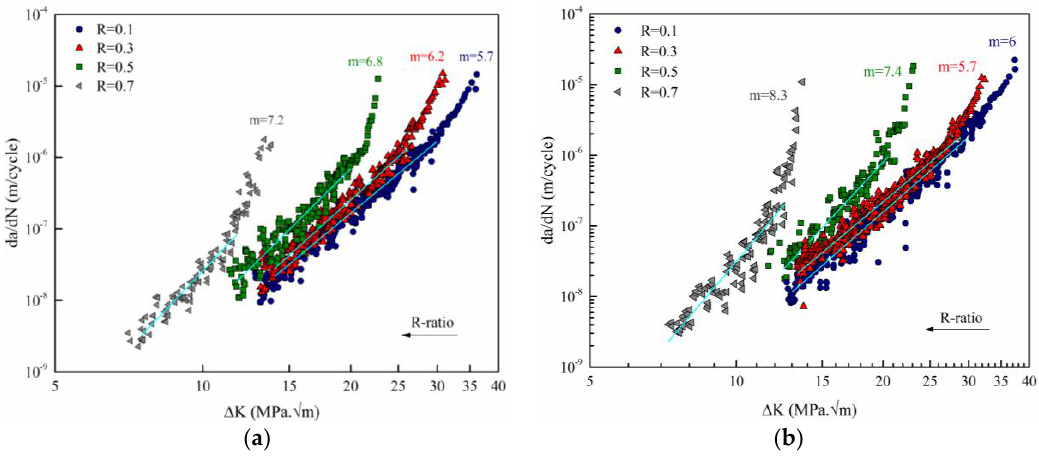
Figure 3. Fatigue crack growth rate vs. stress intensity factor range of the ( a ) admixed and ( b ) pre-alloyed PM steels at four tested R -ratios.